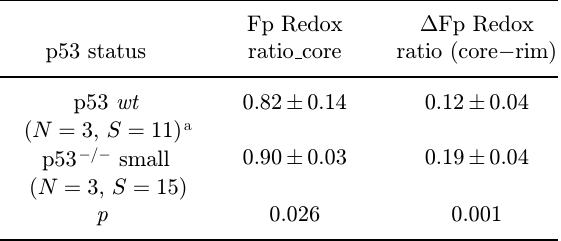
Table 3. The di®erences between the p53 wt and p53 (cid:1) = (cid:1) small groups via the core (cid:1) rim univariate analysis.